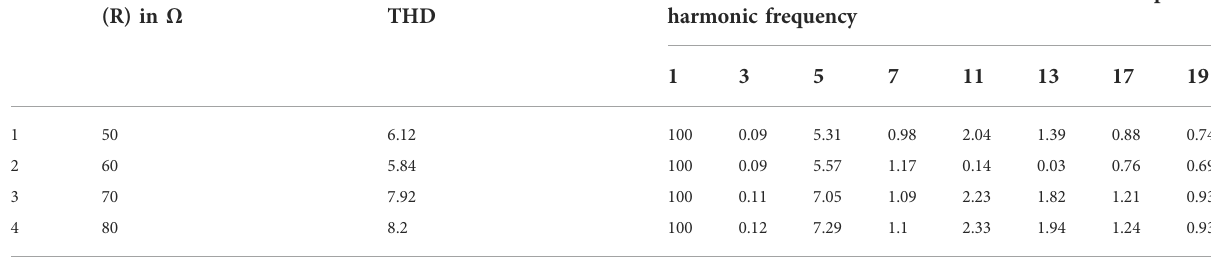
TABLE 7 % THD for varying load conditions.